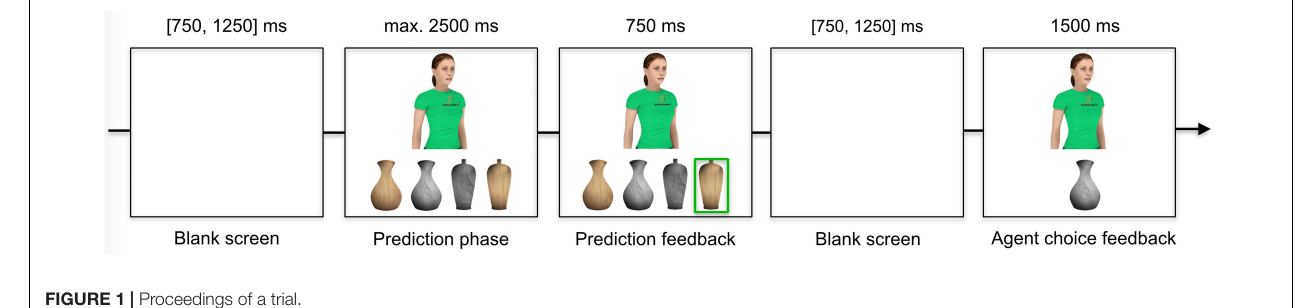
FIGURE 1 | Proceedings of a trial.